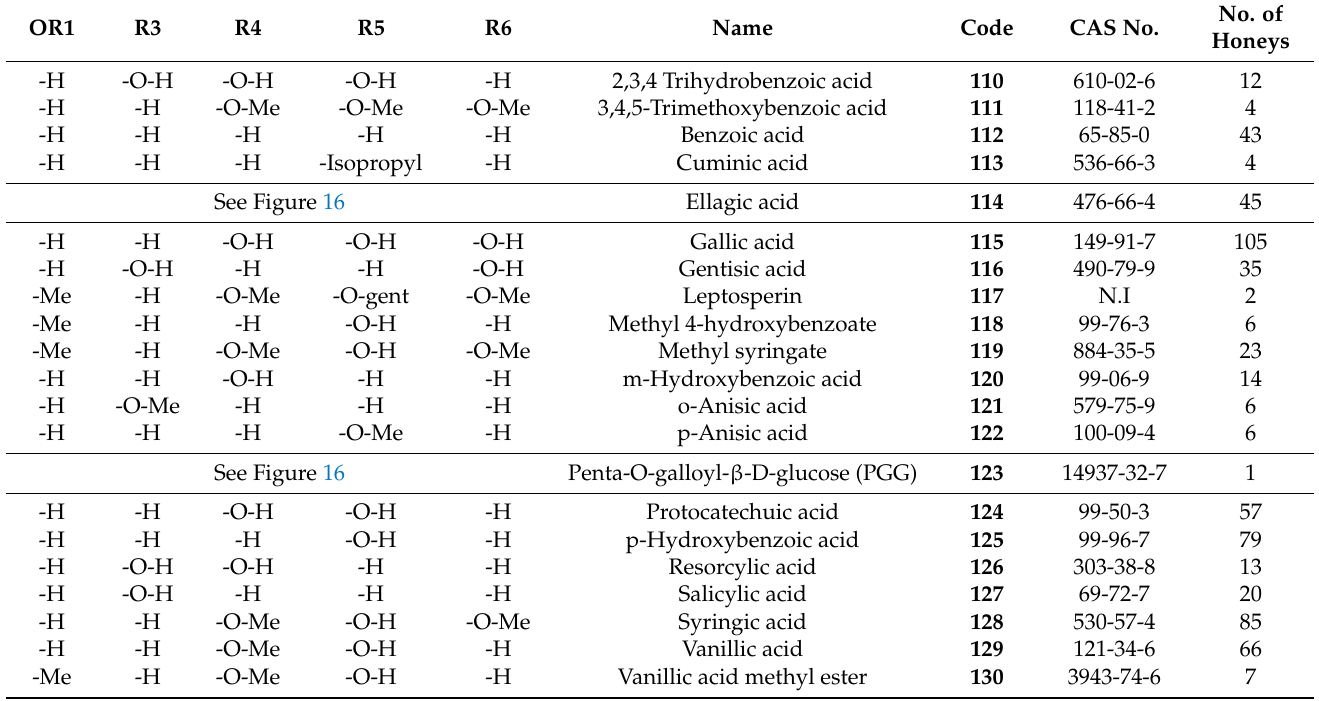
Figure 16. Structure of ellagic acid and penta-O-galloyl- β -D-glucose (PGG) ( 122 – 123 ). Table 10. Hydroxybenzoic acid and its derivatives reported in monofloral honeys (see Figure 15 for general structure, see Figure 16 for ellagic acid and penta-O-galloyl- β -D-glucose (PGG)